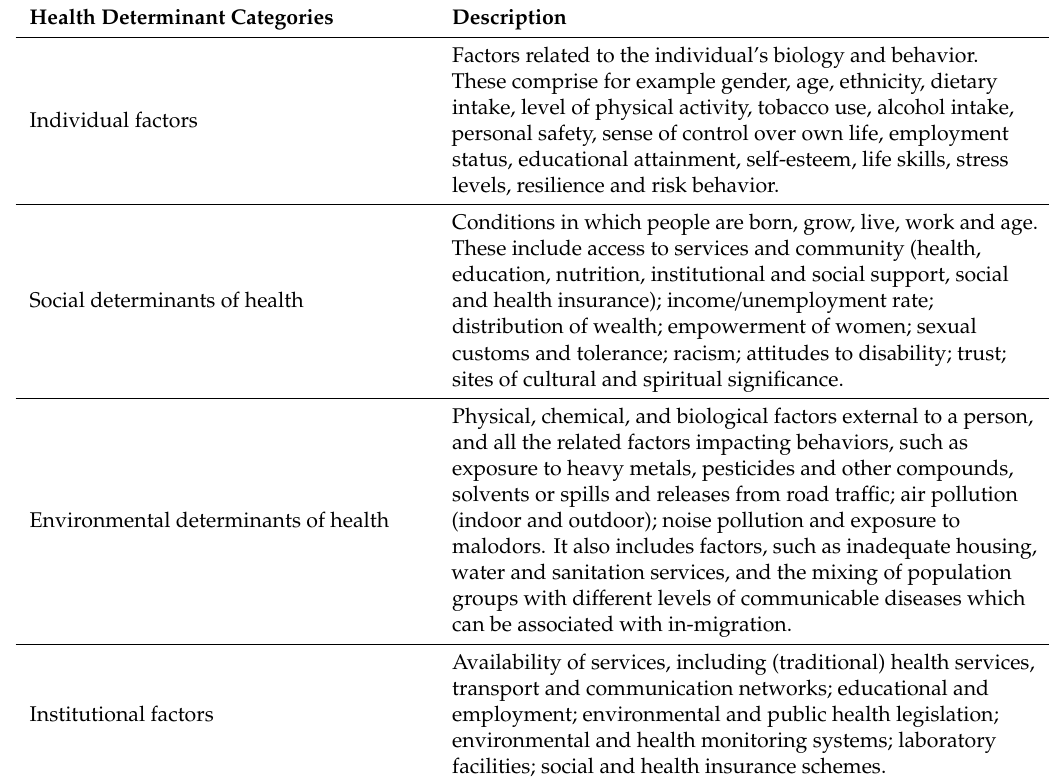
Table A1. Health determinant